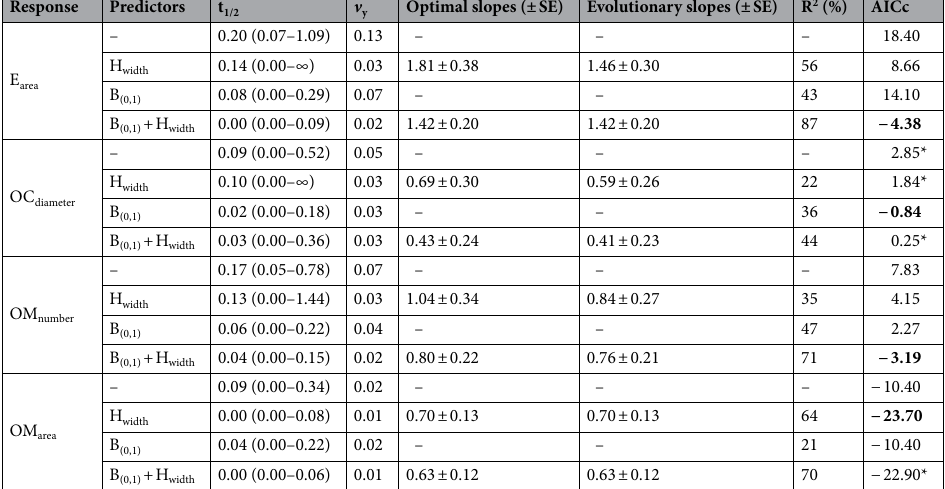
Table 3. Phylogenetic comparative analyses of the evolution of visual system characters in the satellite and the non-satellite species. For each model, we show the maximum-likelihood estimates of phylogenetic half-life, t 1/2 , in units of tree length (total tree length = 1) with its 2LogL support region, the stationary variance, v y , GLS estimates of the slope of the optimal and evolutionary regressions with standard errors (SE). Phylogenetically corrected R 2 , in percentage, represents model fit. The best model from four tested for each response variable is chosen based on the best corrected Akaike Information Criterion (AICc) score and is given in bold. Models with Δ < 4 where Δ measures the information loss (or distance) of each model (AICc i ) in comparison with the best one having the lowest AICc value (AICc min ) according to equation Δ i = AICc i − AICc min , are considered equally supported and are denoted by asterisk. When a “–” is entered for the predictor variable, only an intercept is included in the model. In this cases, the phylogenetic half-life is a measure of the overall phylogenetic effect on the response variable. H = head, E = eye, OM = ommatidia, OC = ocelli, B (0,1) = binary trait describing host-finding strategy (SAT vs.